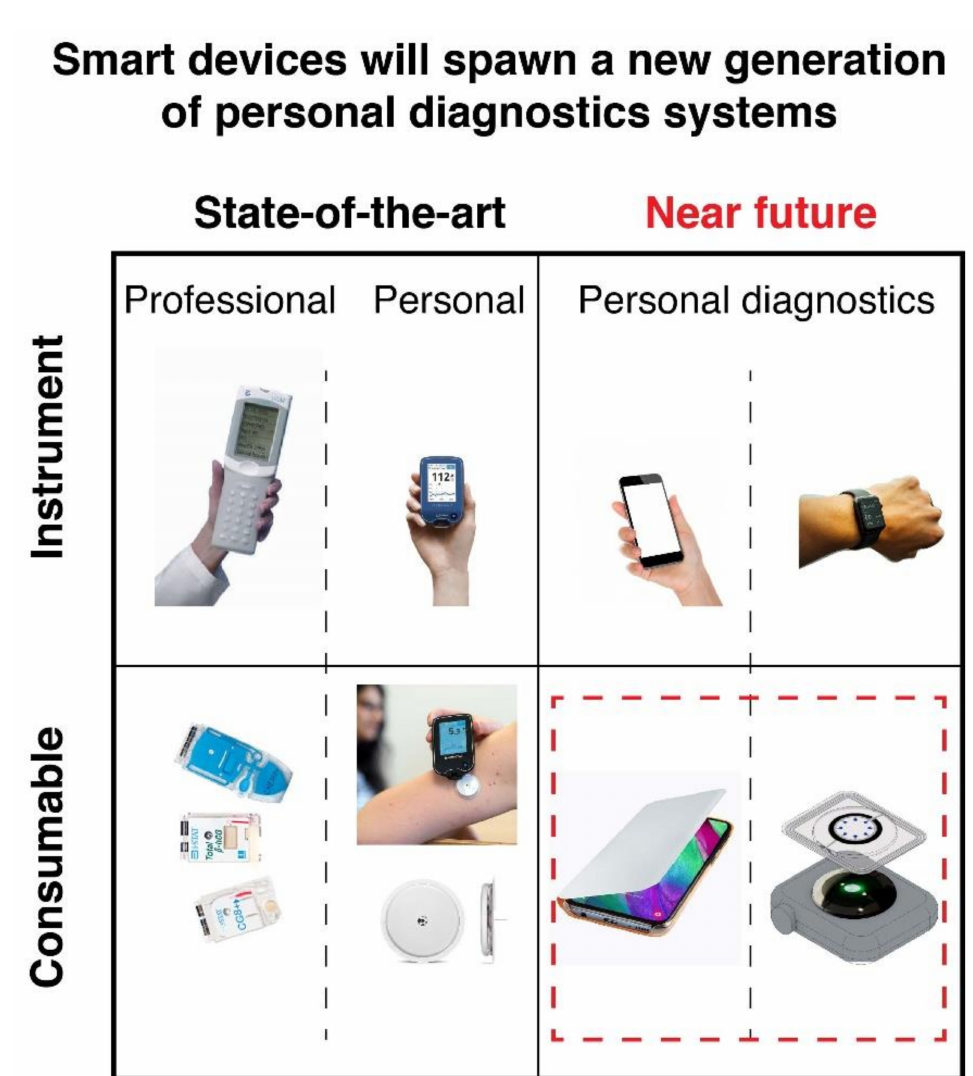
Figure 1. Point-of-care devices are two-part systems targeting professional and personal users. Mobile devices have the potential to replace dedicated instrumentation and lead to a new wave in personalized diagnostics. At the same time, the consumable part will adapt to this new paradigm. The left-hand side features Abbott’s i-Stat system and consumables, and Abbott Freestyle Libre and its biosensing capsule. The right-hand side illustrates the potential use of mobile devices, such as smartphones and smartwatches, to accomplish POC